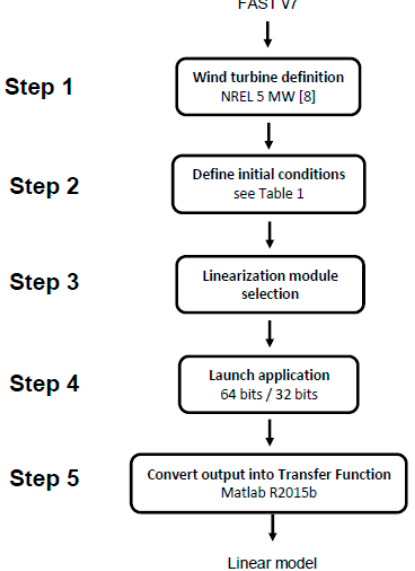
Figure 2. Pole and zero map of the LTI models of the pitch system at various operating conditions.